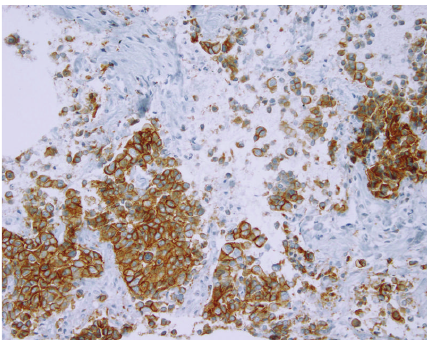
Figure 3: Tumor of the upper urinary tract: biopsy specimen with HER2 overexpression (3+) of tumor cells detected by immunohisto- chemistry (immunoperoxidase staining, primary monoclonal anti- HER2 antibody (clone CB11), original magnification